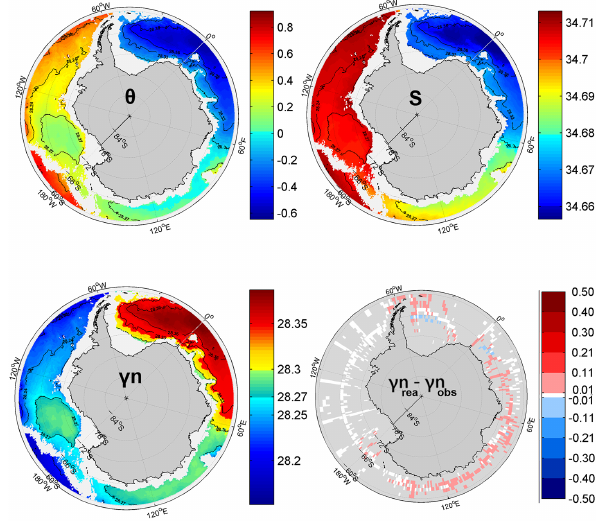
Figure 7. Same as in Fig. 5 except for the BL (3000m to the